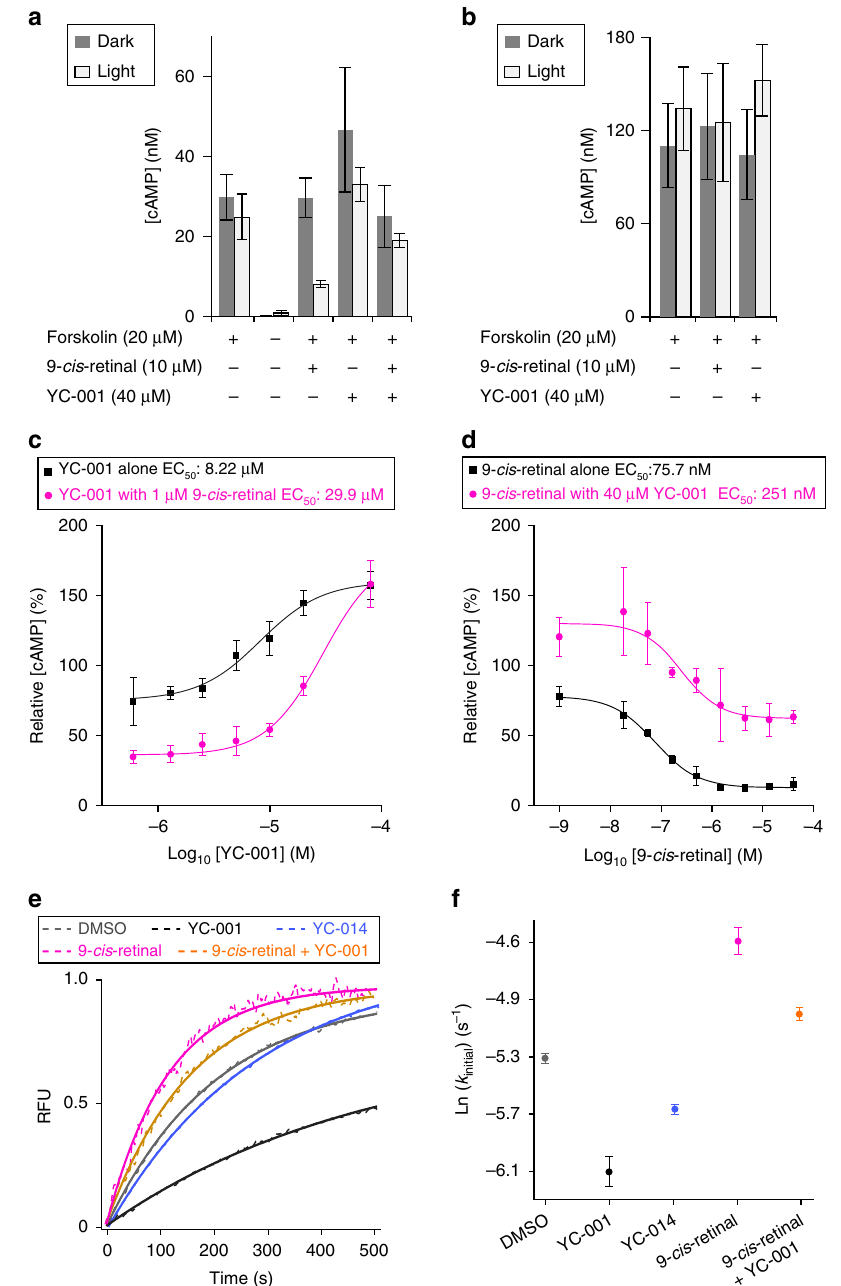
Fig. 5 YC-001 is an inverse agonist and antagonist to rod opsin. Rhodopsin couples to G i / o signaling in a light-dependent manner leading to the reduction of cAMP level in mammalian cells. Forskolin was added to the cells to saturate their cAMP levels. a Levels of cAMP in NIH3T3-(Opsin/GFP) cells treated as noted under the chart. Cells treated in the dark and in light were in gray and white bars, respectively. Bar values are the averages of three replicates, and error bars are s.d.s of the replicates. b Levels of cAMP in NIH3T3-(GFP) cells treated with PBS, 10 µ M 9- cis -retinal, or 40 µ M YC-001, respectively. c cAMP levels in NIH3T3-(Opsin/GFP) cells treated with a series of YC-001 doses in the presence (magenta circles) or absence of 1 µ M of 9- cis -retinal (black squares) under light. Doses of YC-001 tested were 80, 20, 10, 5, 2.5, 1.25, 0.625, and 0.313 µ M. The cAMP level in cells treated with forskolin only was normalized as 100%, and that treated without forskolin as 0%. d cAMP levels in NIH3T3-(Opsin/GFP) cells treated with a dose series of 9- cis -retinal in the presence (magenta circles) or absence of 40 µ M of YC-001 (black squares) under light. Doses of 9- cis -retinal tested were 40, 13.3, 4.44, 1.48, 0.494, 0.165, 0.055, 0.018, and 0.001 µ M. e G t activation by bovine rod opsin or isorhodopsin. Constitutive activity of bovine opsin in disc membranes or photoactivated isorhodopsin activity was recorded by fl uorescence with excitation and emission at 300 and 345 nm, respectively, as a function of time, due to GTP γ S-induced dissociation of the opsin/isorhodopsin: G t complex. Dashed experimental lines were fi tted by the fi rst-order exponential decay functions shown in solid lines. Each condition was repeated in three biological replicates and initial rates and error bars were averages and s.d.s. shown in f . Opsin were treated with DMSO (gray), 40 µ M YC-001 (black), 40 µ M YC-014 (blue), 40 µ M 9- cis -retinal (magenta), and a mixture of 40 µ M 9- cis -retinal and 40 µ M YC-001 (orange). Each experiment was repeated